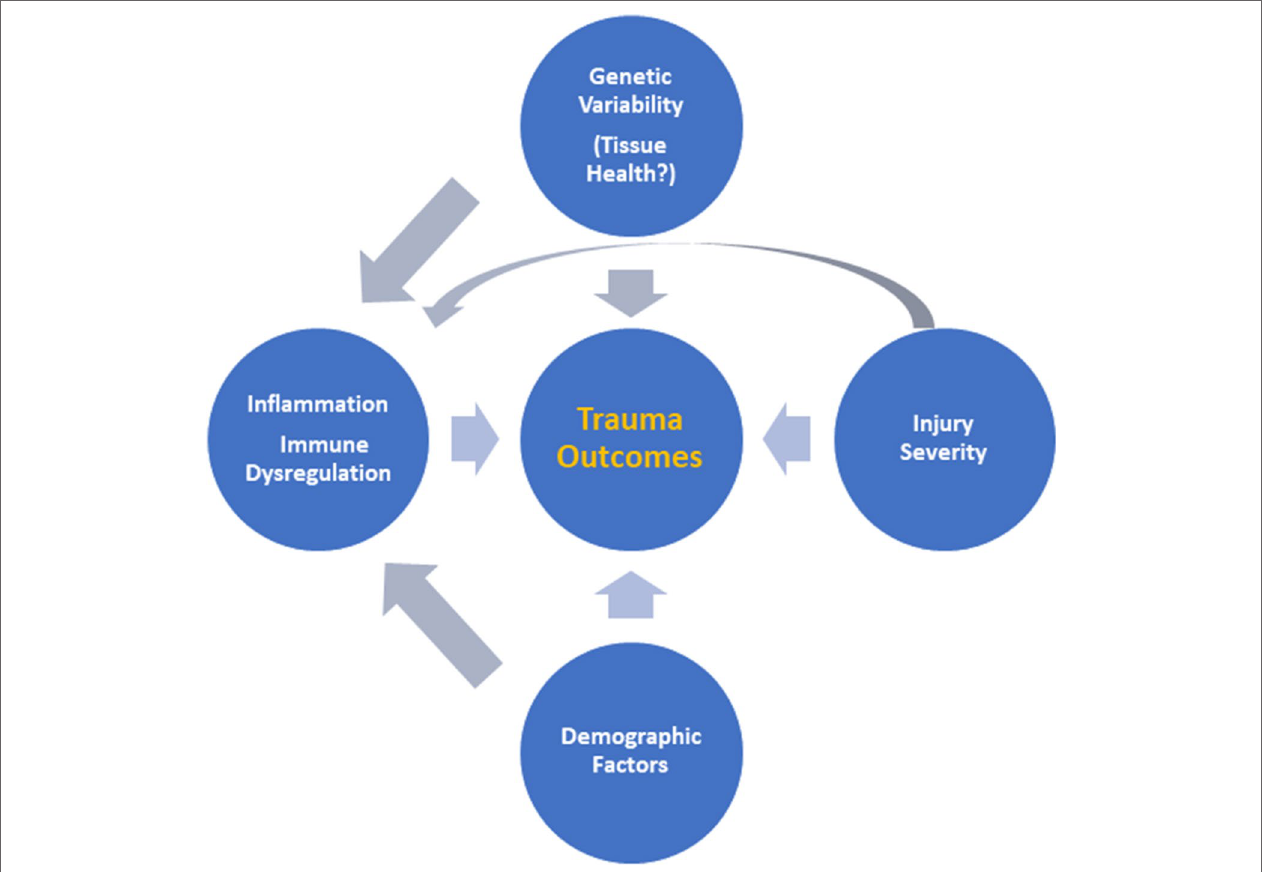
FIgUre 4 | Putative interactions among injury severity, inherent tissue resilience, and the systemic inflammatory response. Based on the results presented in this study, we suggest an intertwined interaction among injury severity, inherent (genetically determined) tissue resilience, and the systemic inflammatory response driving outcomes after trauma as a novel paradigm for understanding the response to traumatic